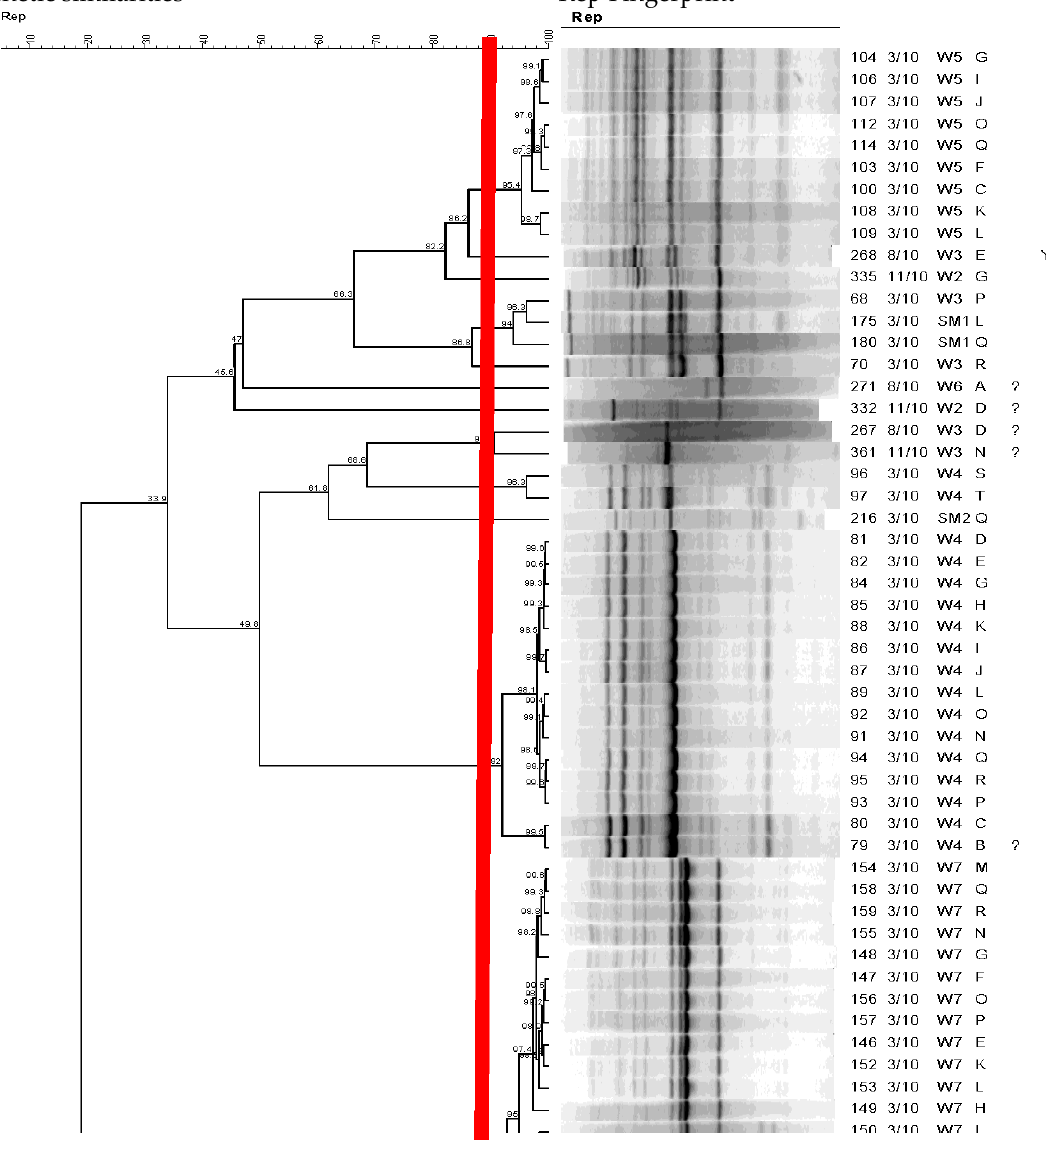
Figure 3. Dendrogram showing the genetic relatedness of E. coli from wetland based on their rep-PCR DNA fingerprints as an example. The red vertical line indicates the cutoff value for identifying unique genotypes.